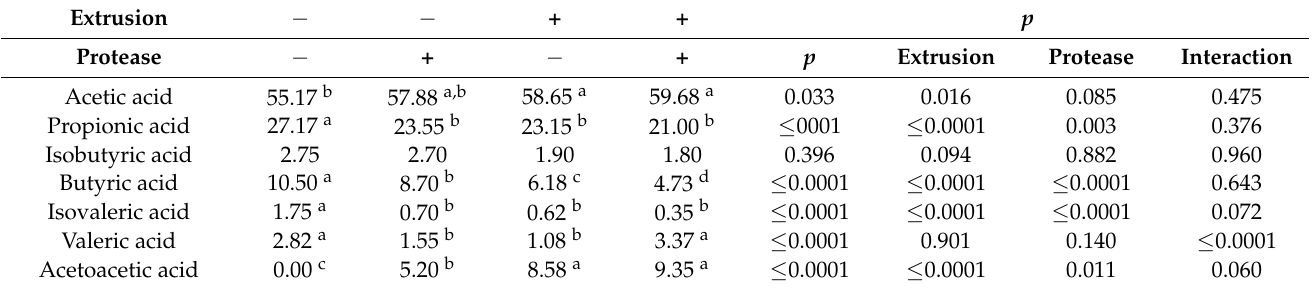
Table 6. The concentration of short-chain fatty acids ( µ mol/g digesta) in the pigs’ cecal digesta ( n = 8).